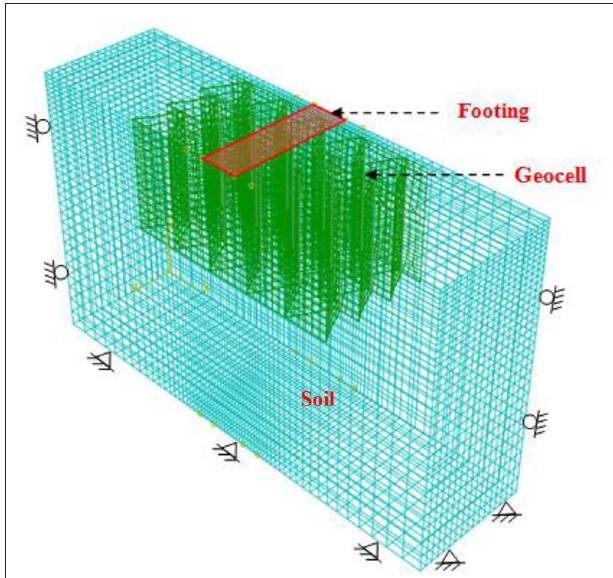
FIGURE 4 | ABAQUS model for geocell reinforced foundation bed.